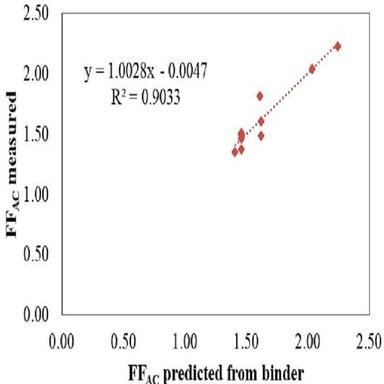
Relationship between the FFFAM measured and predicted from a power law equation considering a) two binder variables, and b) three binder variables.